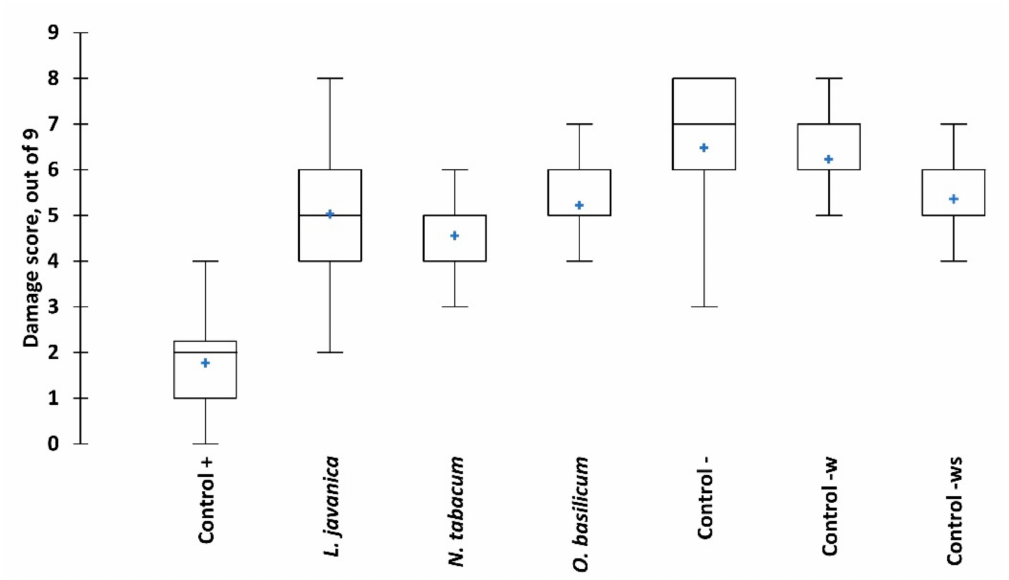
Figure 4. Fall armyworm damage to maize plants when exposed to di ff erent treatments over eight weeks. Boxes represent mean and 95% confidence intervals, tails are max. and min. values, blue crosses are median values. Significant di ff erences are presented in Table